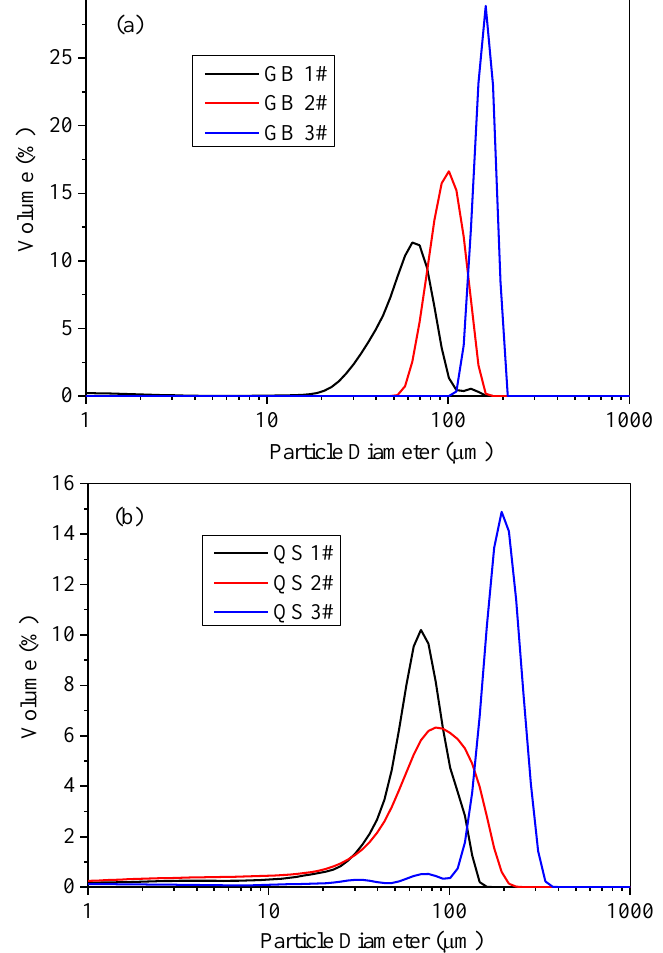
Figure 5. Particle size distribution: ( a ) Glass beads; ( b ) Quartz